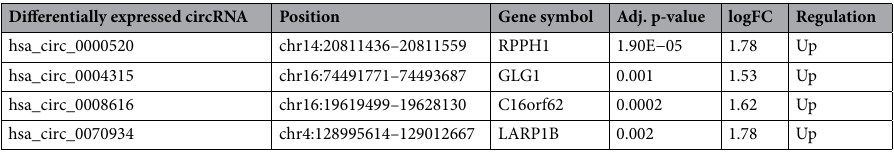
PLK4. (Fig. 9B) Following that, the DEC-FImiRNA-hub gene network was constructed, including two circRNAs